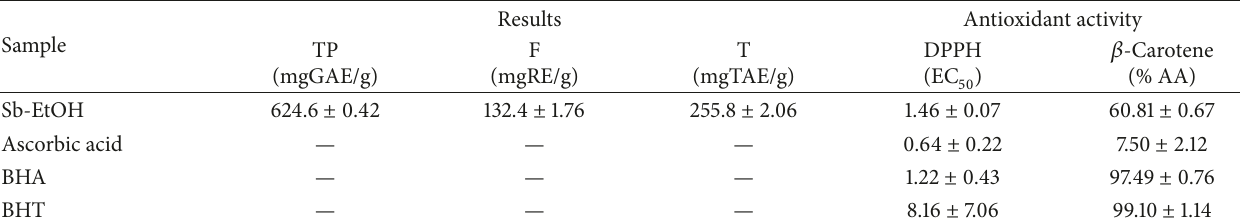
Table 3: The content of total phenols (FT), flavonoid (F), tannins (T), and antioxidant activity were determined by DPPH (EC 50 ) and 𝛽 - carotene (% AA).